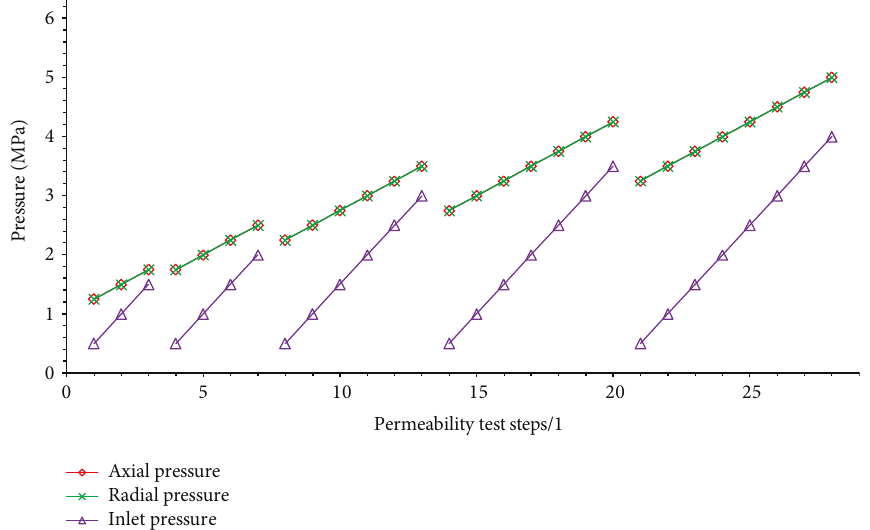
Figure 4: Tests on the pore pressure e ff ect on the permeability under constant average e ff ective